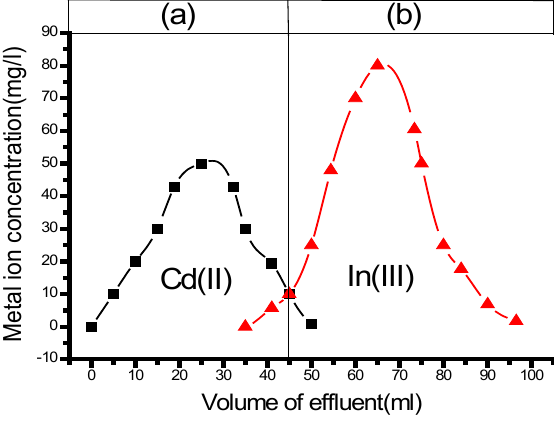
Figure 6. Elution curve of separation of In(III) and Cd(II) from Dowex 50w-x8 using (a) 0.05 M HNO